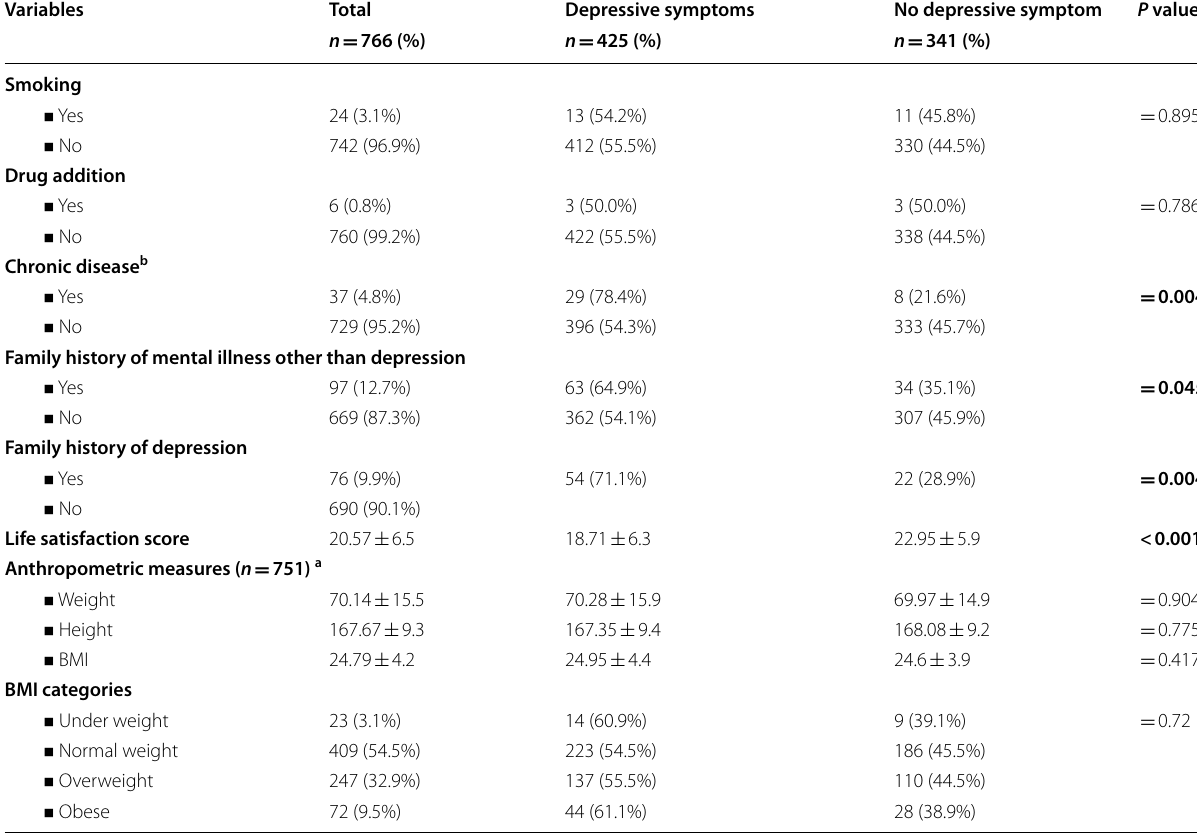
Table 2 Association between students’ health profile and depressive symptoms